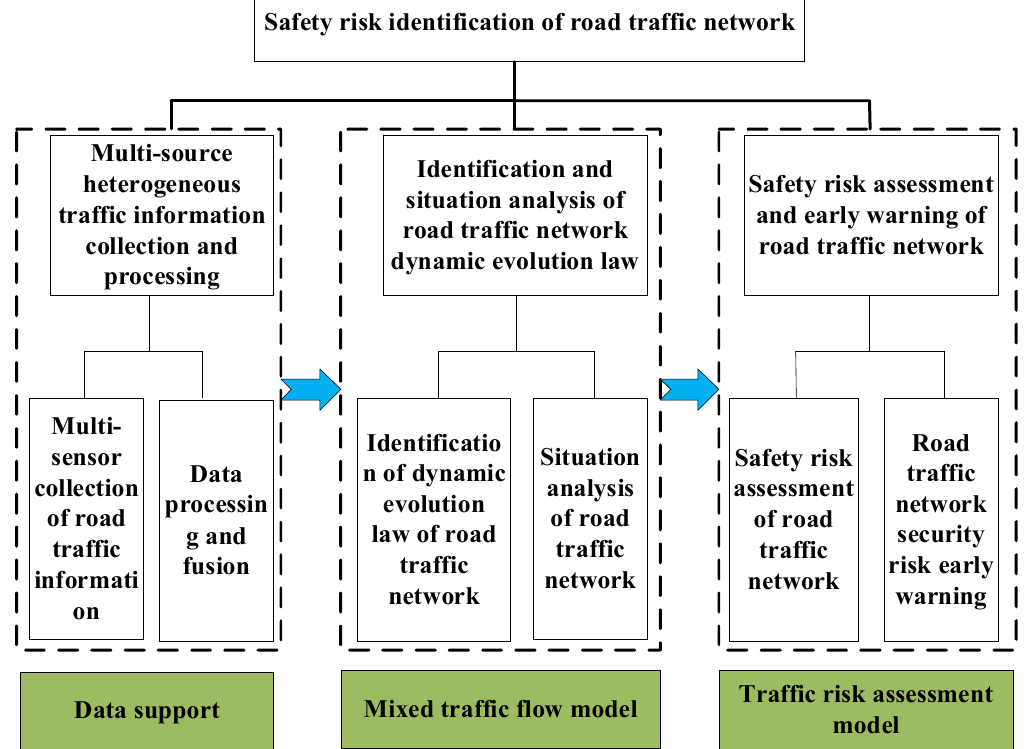
Figure 3. Research framework of road traffic network security risk identification.